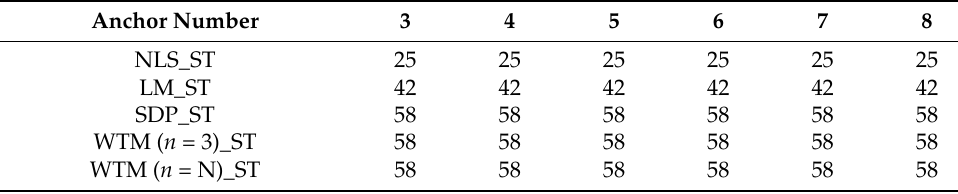
Table 3. Simulation time for one localization process in milliseconds.